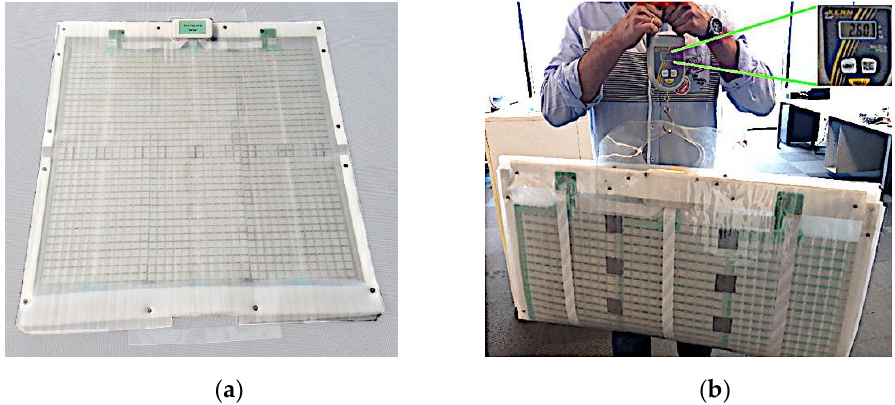
Figure 3. ( a ) Most recent version of the Equimetrix sensing mat and ( b ) its weight measurement (2.6 kg) in the folded transport configuration.